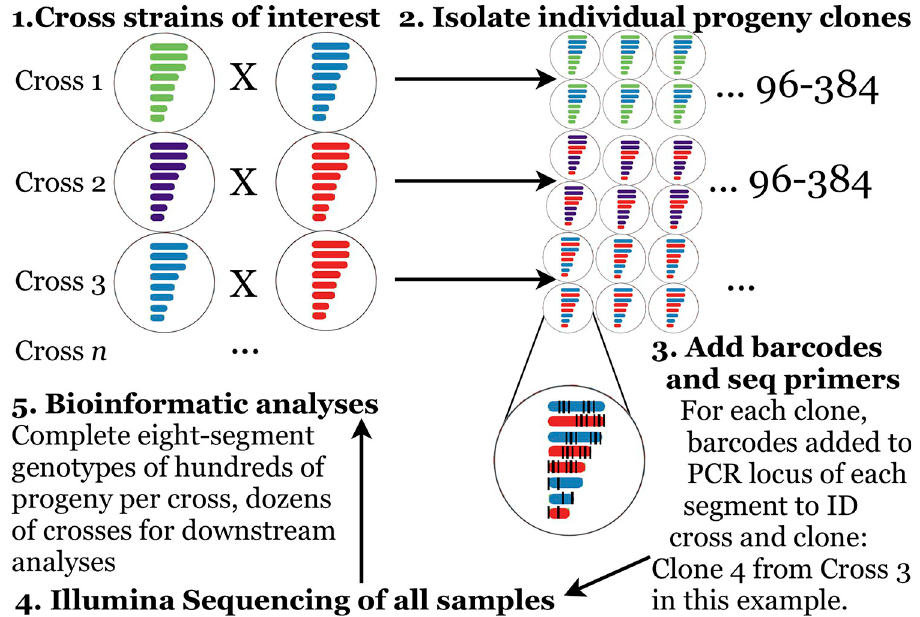
Fig 1. Overall experimental workflow for experimental co- infections, progeny clone isolation, and genotyping.